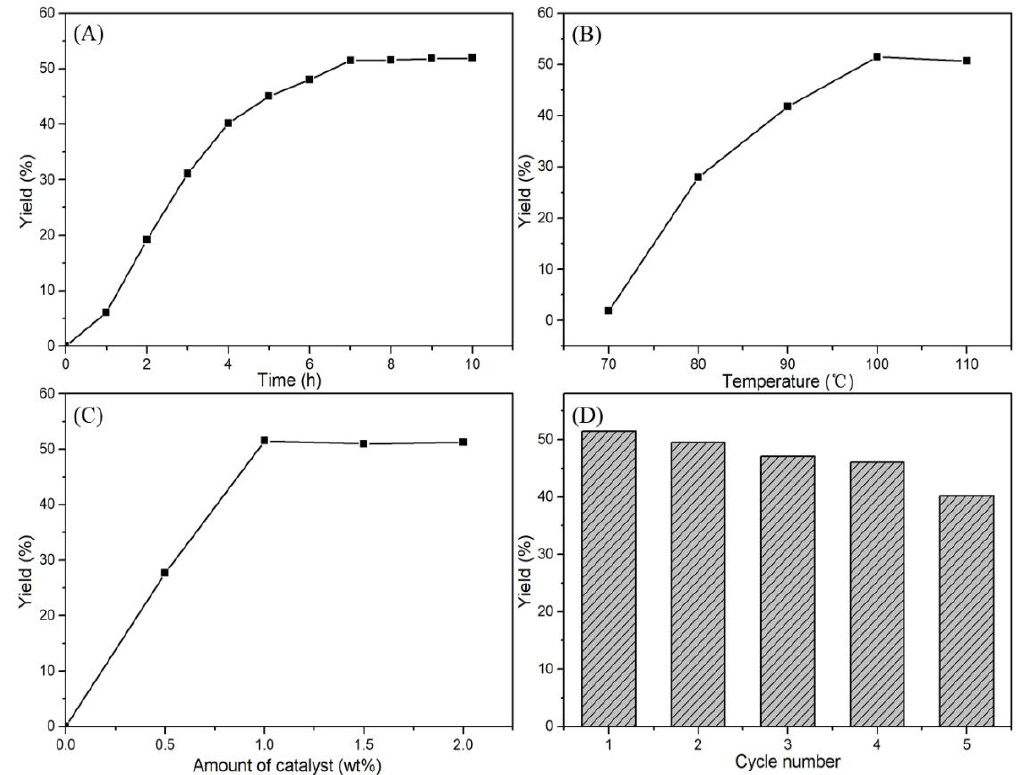
Figure 6. ( A ) Effect of time (100 °C, 1 wt% catalyst amount); ( B ) effect of temperature (7 h, 100 °C, 1 wt% catalyst amount); ( C ) effect of catalyst amount (7 h, 100 °C); ( D ) reusability of the catalyst ZnCo/NC-600 (7 h, 100 °C, 1 wt% catalyst amount).